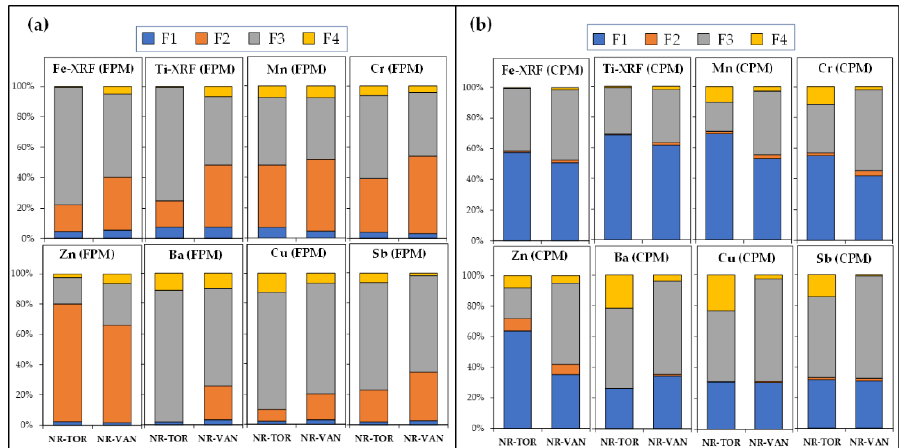
Figure 6. The relative contribution of PMF-resolved sources to individual redox-active metals in ( a ) PM 2.5 (FPM), and ( b ) PM 10-2.5 (CPM). F1 = Mineral/Road Dust; F2 = Regional/Local Industry; F3 = Brake/Tire Wear; F4 = Unexplained.